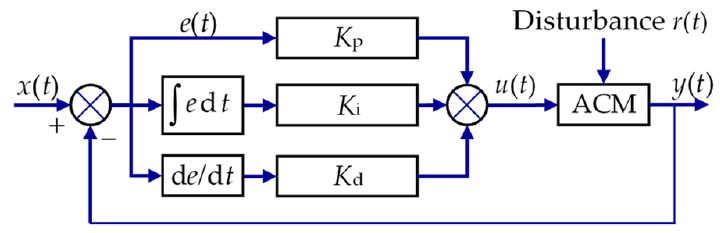
Figure 6. PID feedback control block diagram.